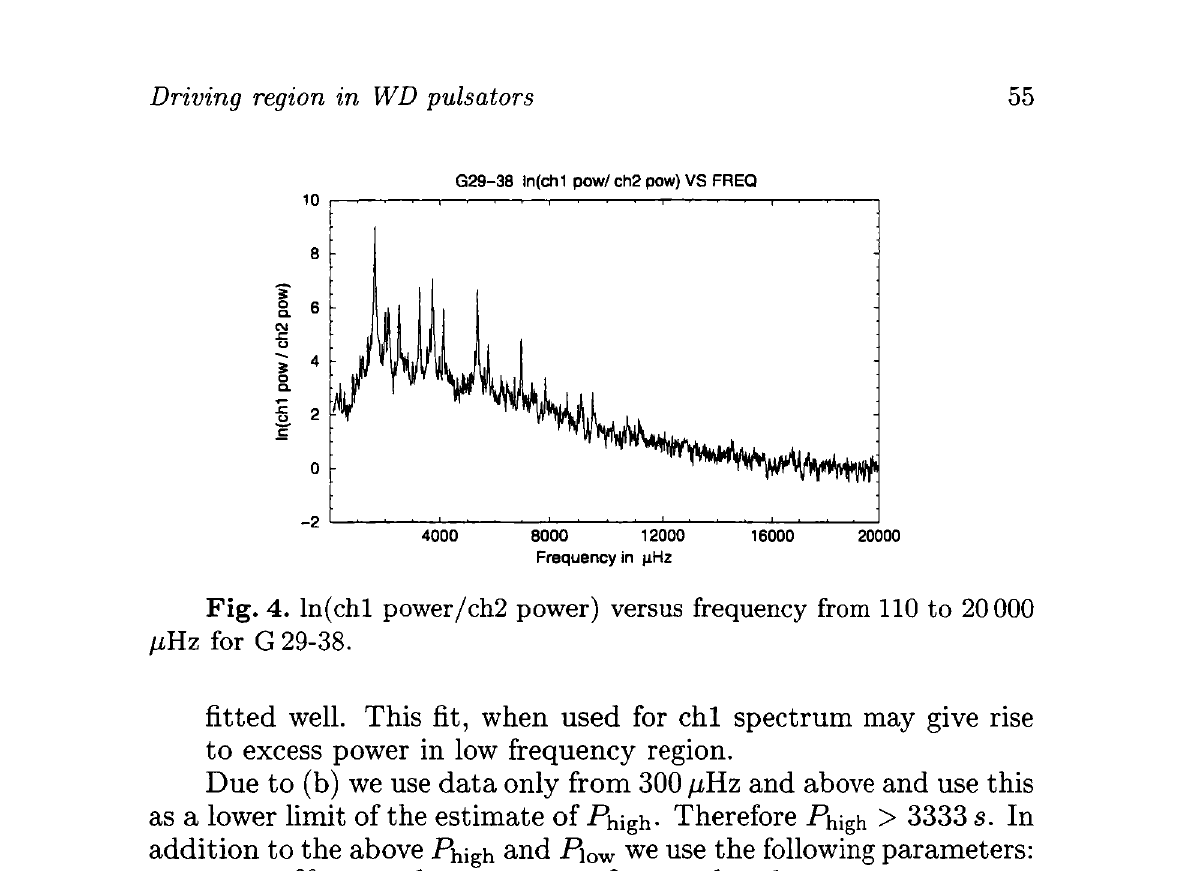
Fig. 4. ln(chl power/ch2 power) versus frequency from 110 to 20000 /xHz for G